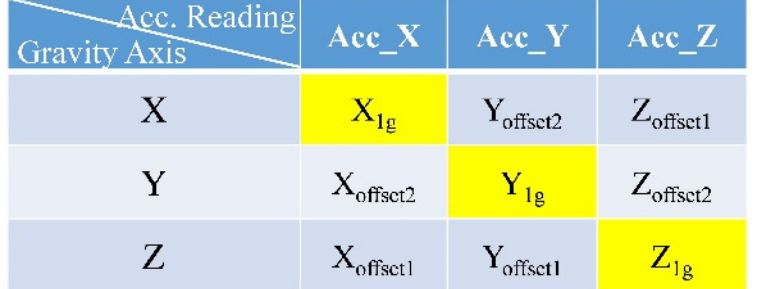
Figure 7. Acceleration readings obtained from the BASIC module for calibration.